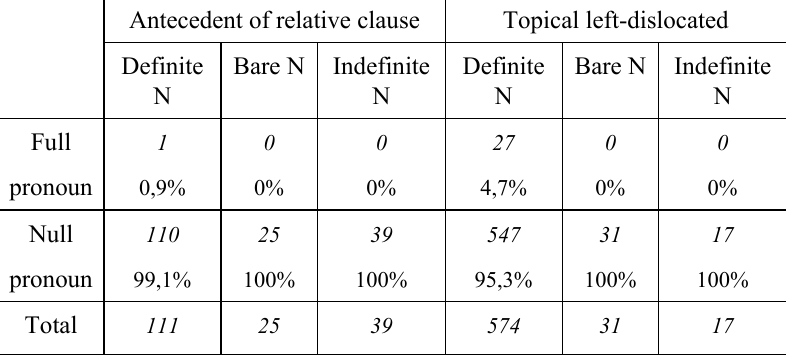
Table III: Pronominalization frequency: the definiteness scale Antecedent of relative